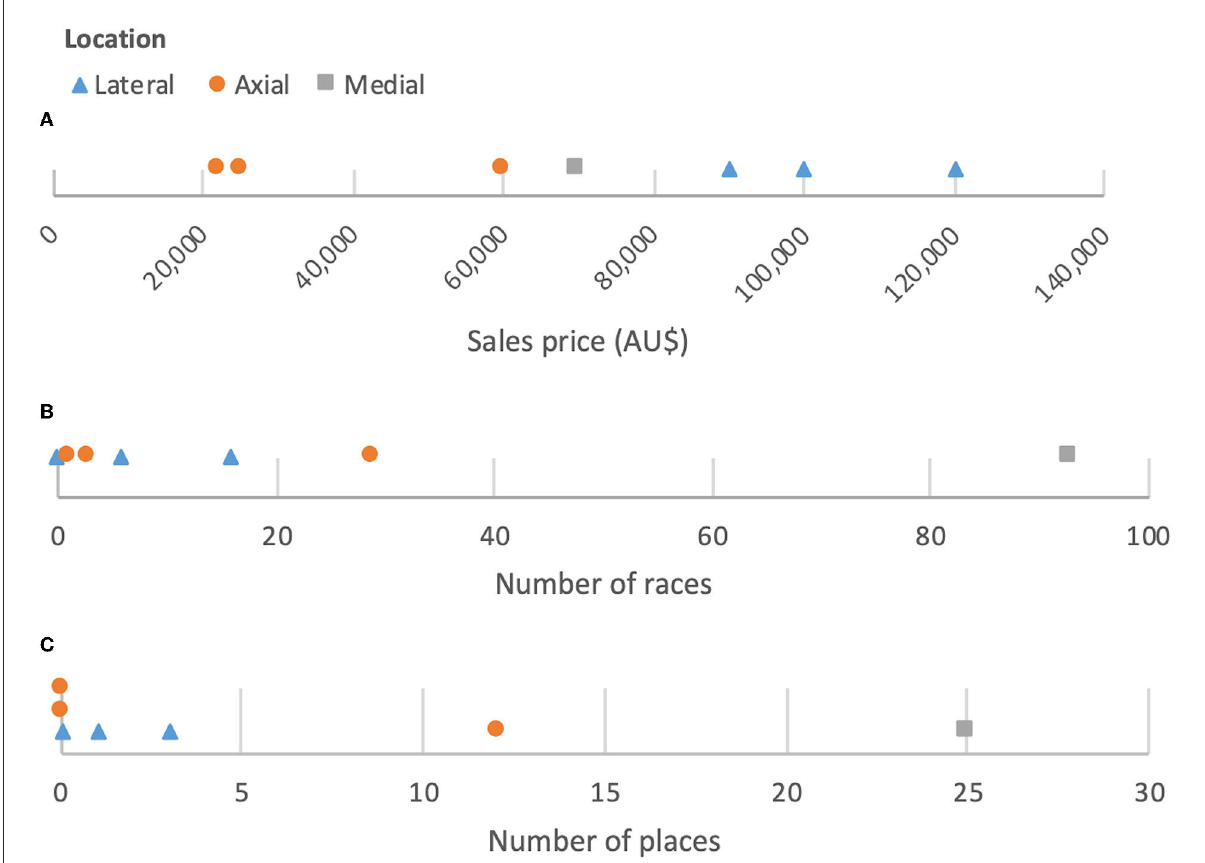
FIGURE6 Line plots showing distribution of P2SC location on dorsopalmar/plantar radiograph by (A) sales price, (B) number of races, and (C) number of places ( N =